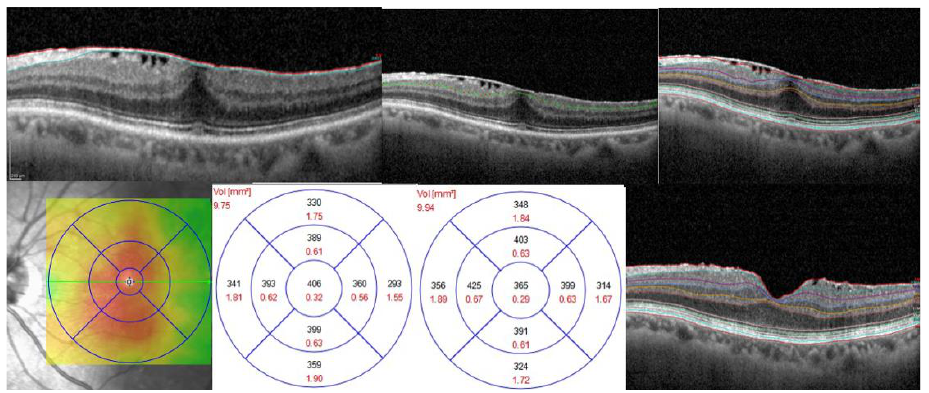
Figure 1. Example of retinal layer segmentation. Upper row (preoperative images): ( left ) example of bad RNFL segmentation; ( middle ) example of resegmentation of GCL; ( right ) segmentation of each retinal layer. Lower row: ( left ) preoperative heat map showing retinal thickness distribution; middle ( left ) ETDRS grid showing mean retinal thickness for each region. The central values ( fovea ) were considered for our analysis; ( middle right ) postoperative values of retinal thickness; ( Right ) postoperative segmentation.